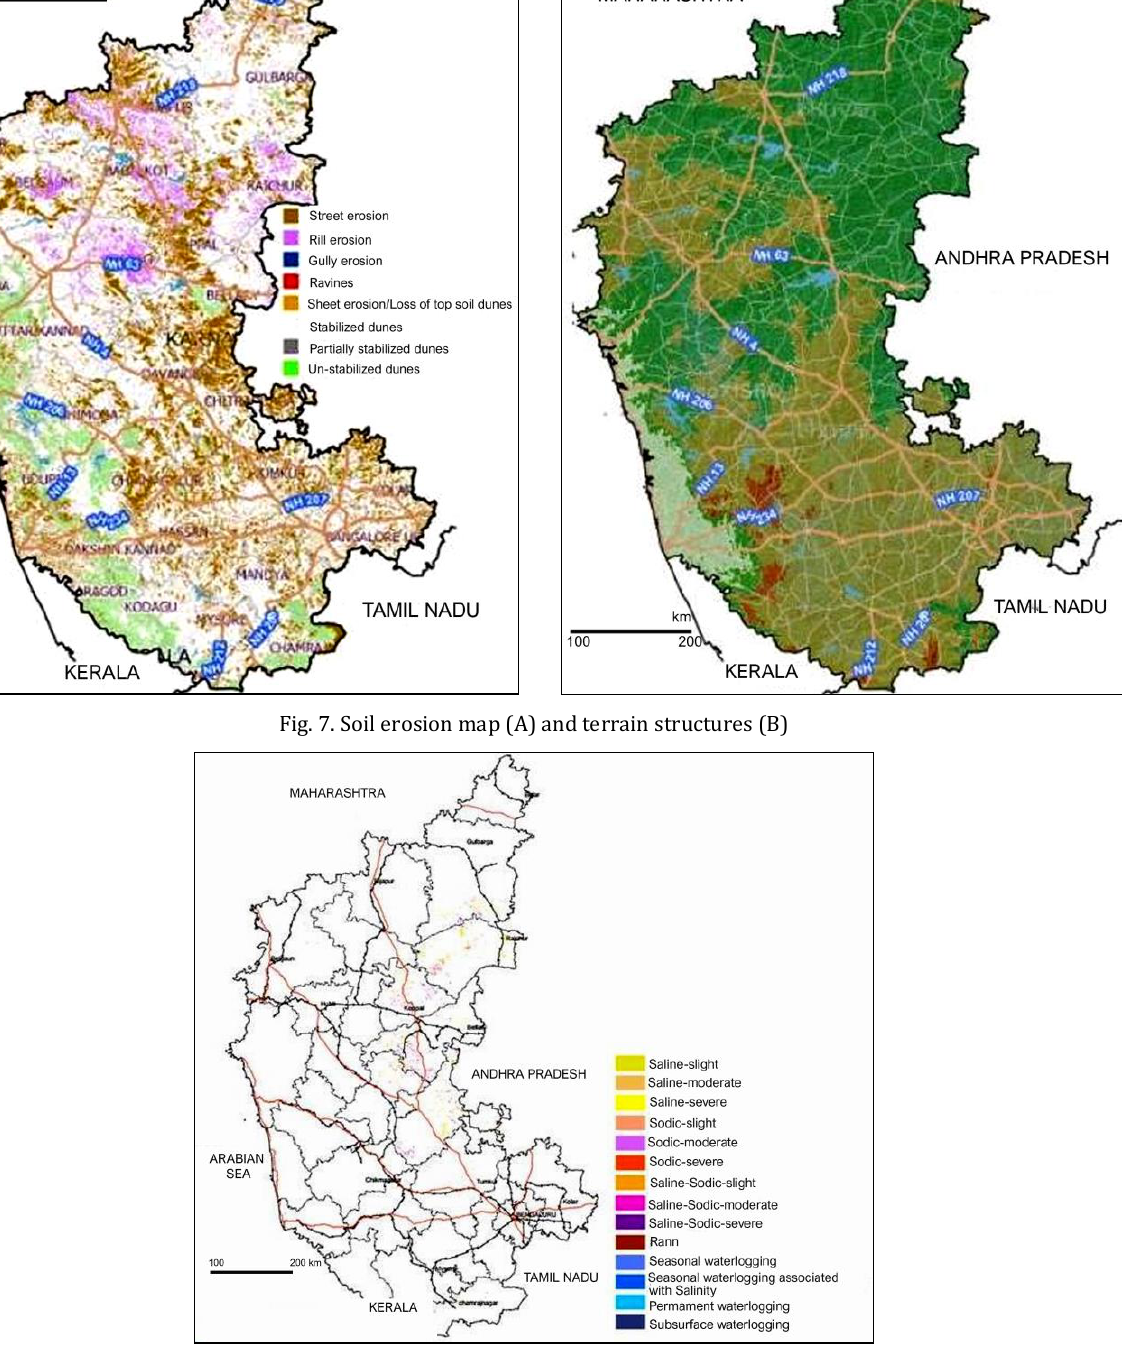
Fig. 8. Salt affected and water logged